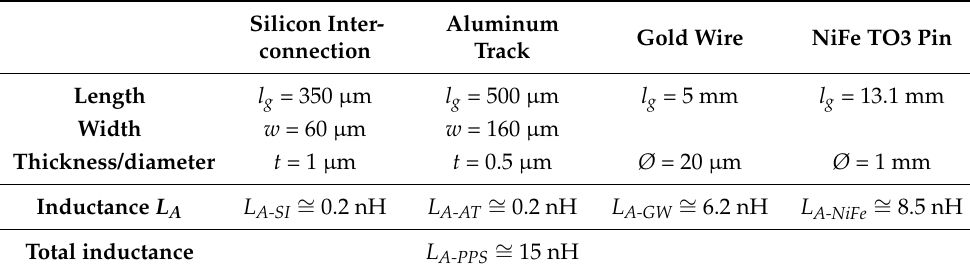
Table 5. Dimensions and estimated values of the different equivalent inductances inside of the sensor. Silicon Inter-